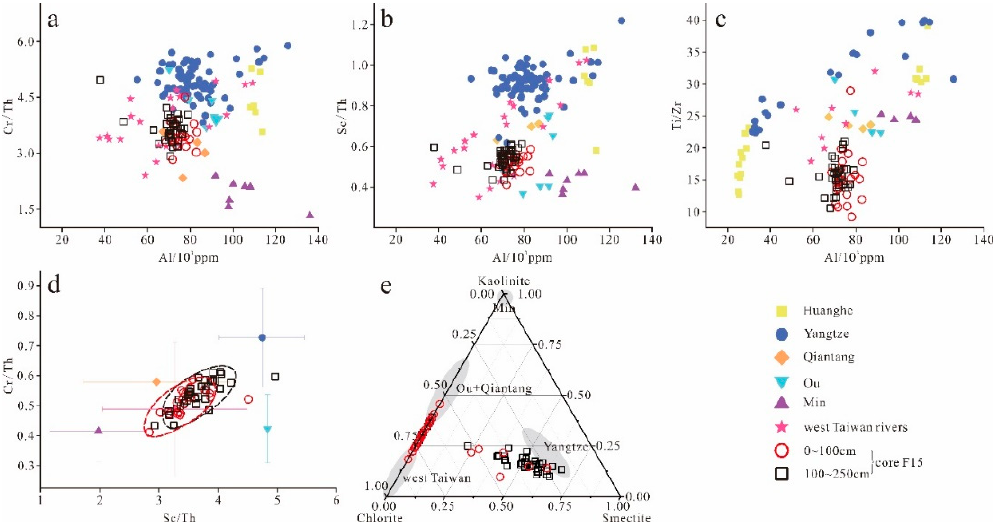
Figure 5. Sediment provenance discrimination of core F15 based on the residual phase using the approaches of Cr/Th–Al ( a ), Sc/Th–Al ( b ), Ti/Zr–Al ( c ), and Cr/Th–Sc/Th ( d ) with sediment <45 µm. ( e ) Provenance discrimination from clay minerals of core F15 [45].